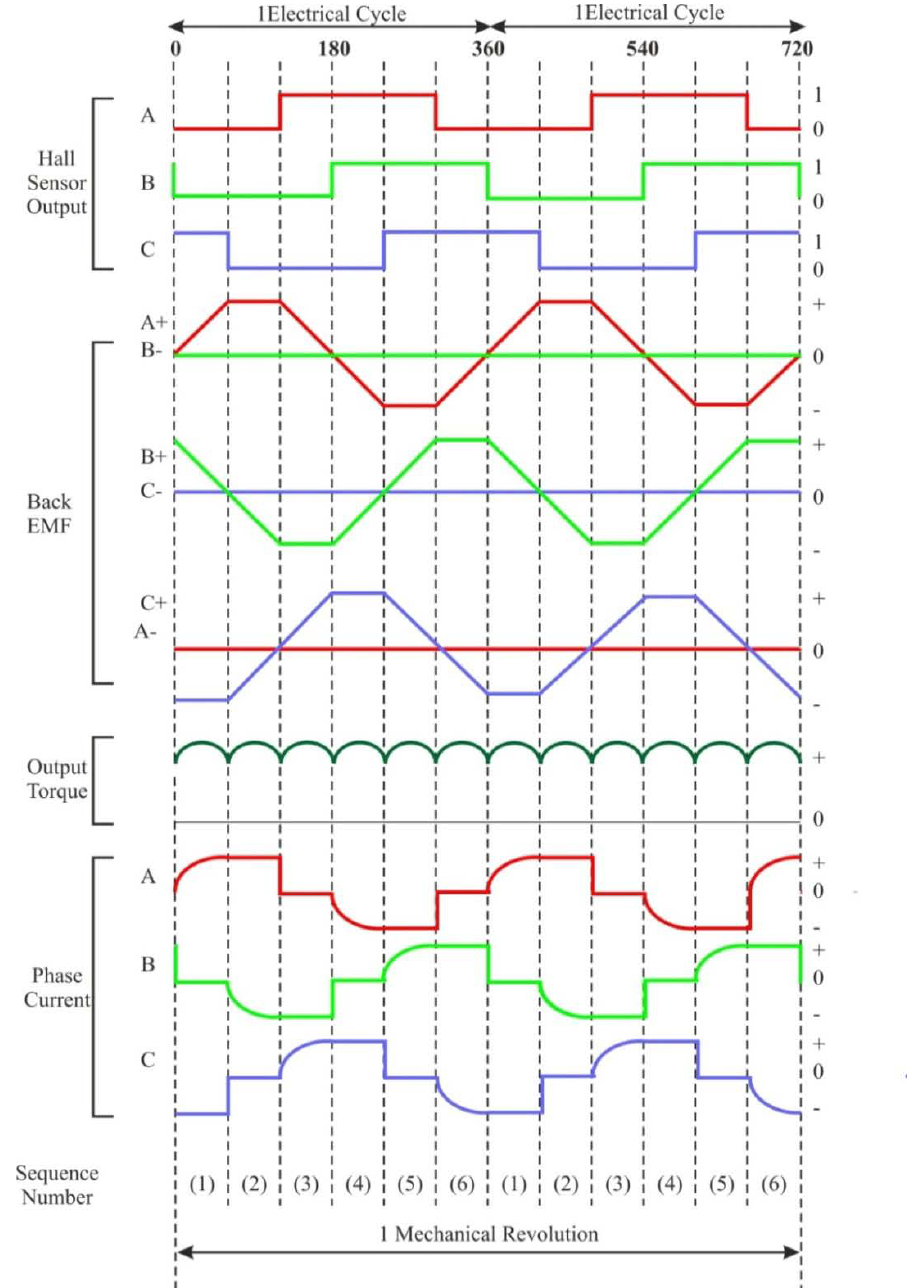
Figure 6. Hall sensor signal, back-EMF, output torque and phase current